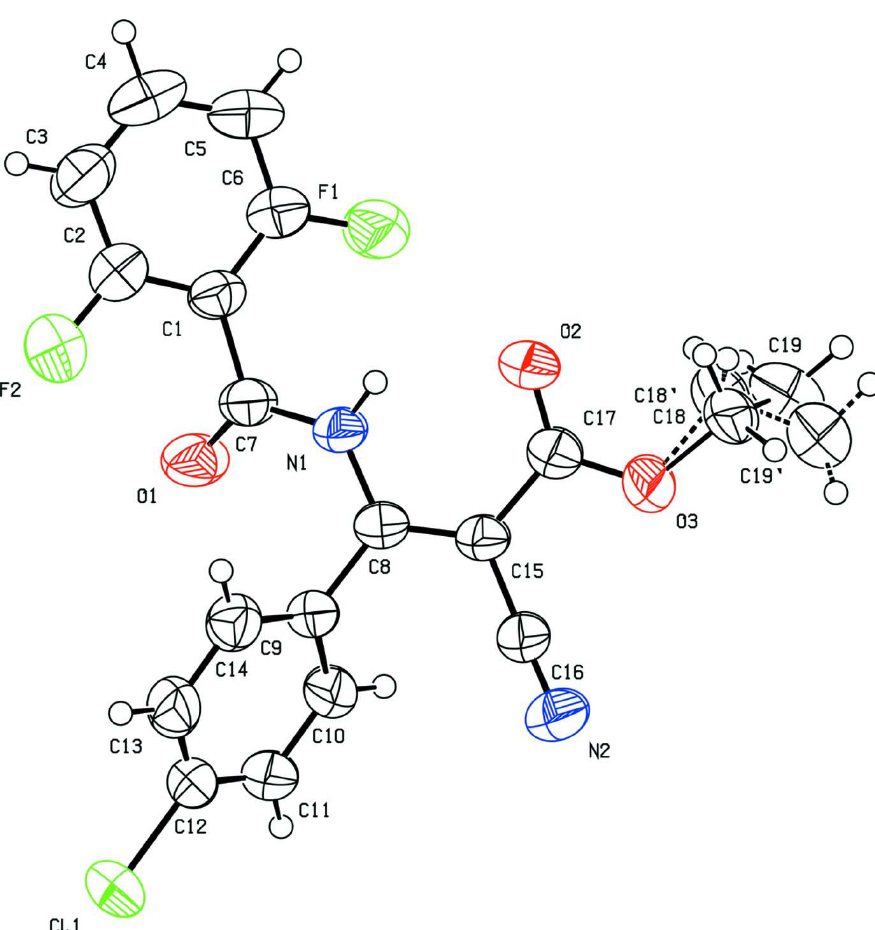
Figure 1 The molecular structure of the title compound, showing 30% probability displacement ellipsoids and the atom-numbering